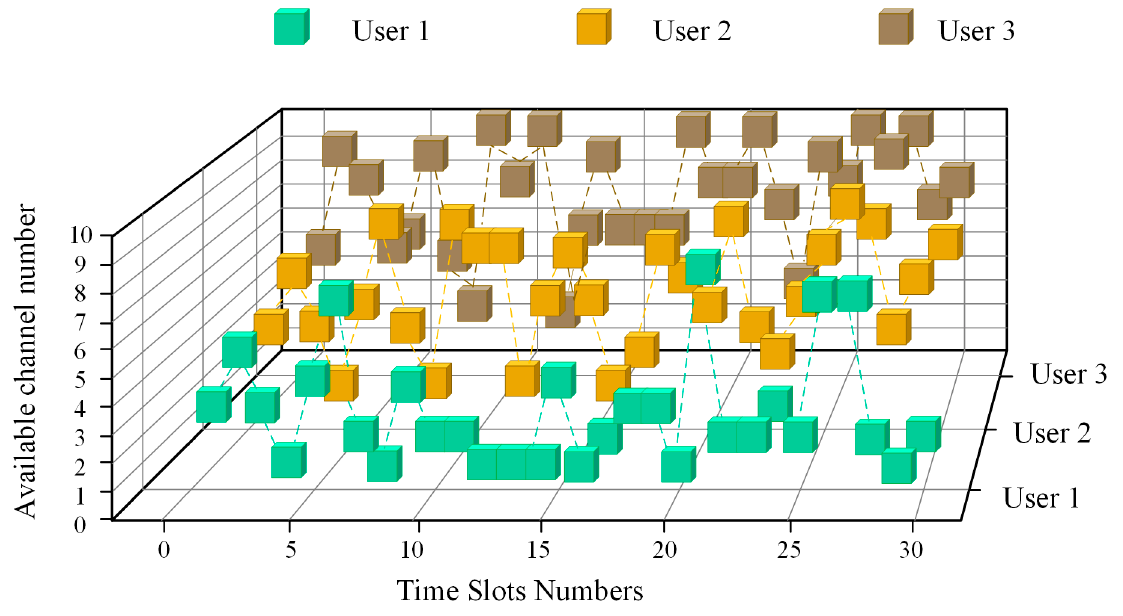
Figure 5. Schematic diagram of 3-user system time slot-channel selection cube, including the central base station.